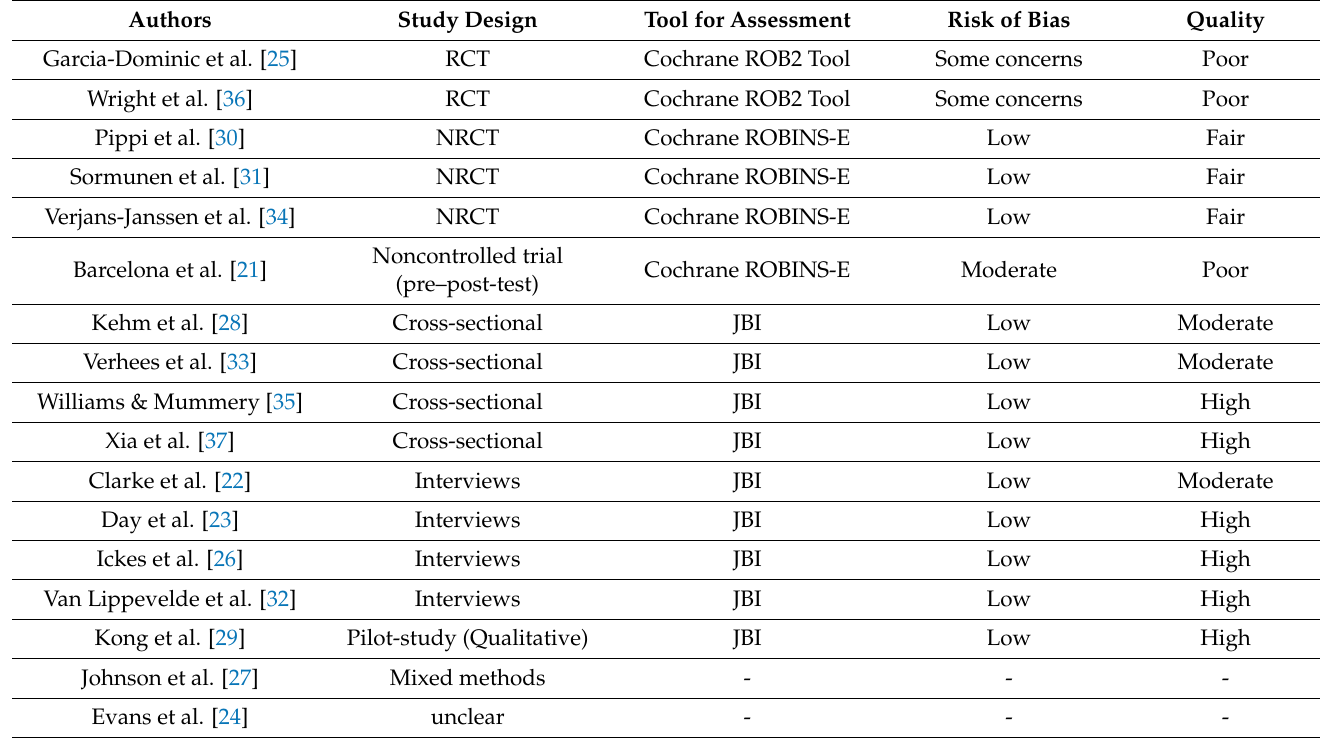
Table 2. Quality assessment of the studies